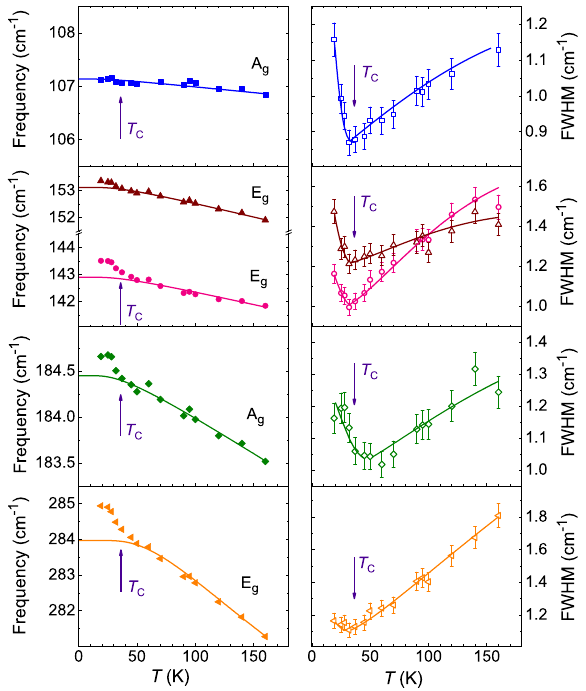
Fig. 5 The temperature dependences of selected Raman peak frequencies and full-width at half-maximum (FWHM). The solid lines represent the fi tting results in the anharmonic approach as described in the